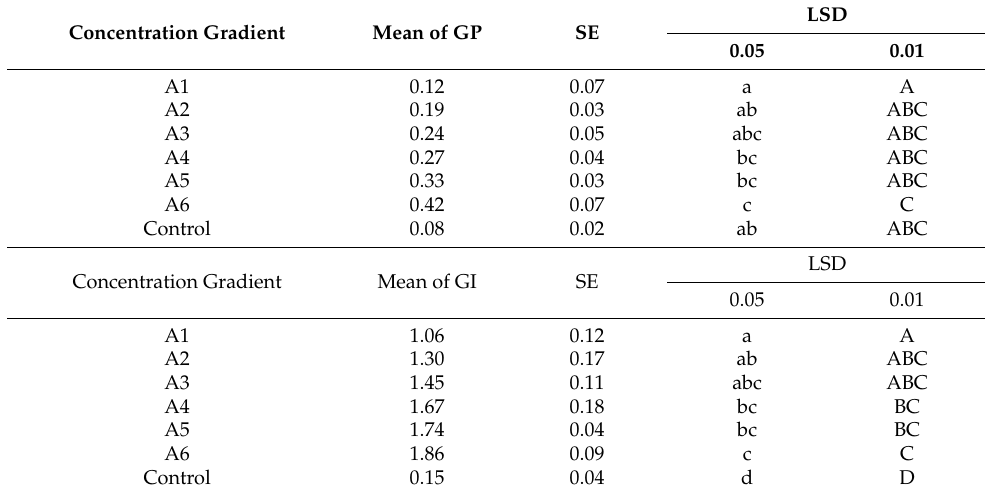
Table 4. Multiple comparisons for the effects of increasing concentrations of GA 3 on GP and GI. A1-A6 are 200, 500, 1000, 1500, 2000, 2500 mg · L − 1 GA 3, respectively. SE is standard error and LSD is Fisher’s Least Significant Difference at p ≤ 0.05 and 0.01.